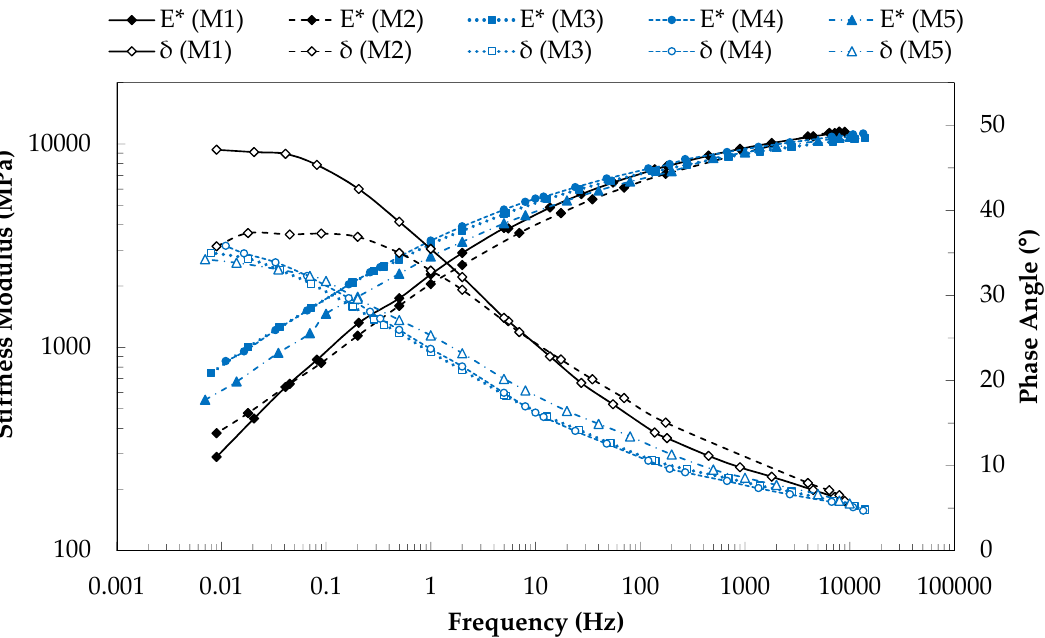
Figure 11. Master curves of the stiffness modulus and phase angle of the studied mixtures for a reference temperature of 20 °C.